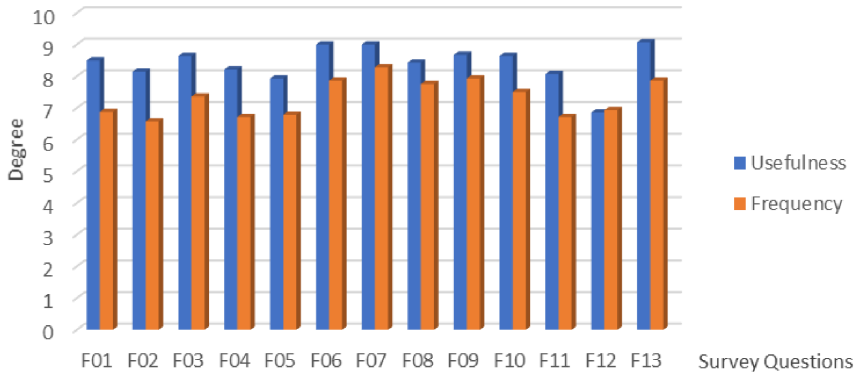
Figure 6. Usefulness and frequency result toward PITON’s